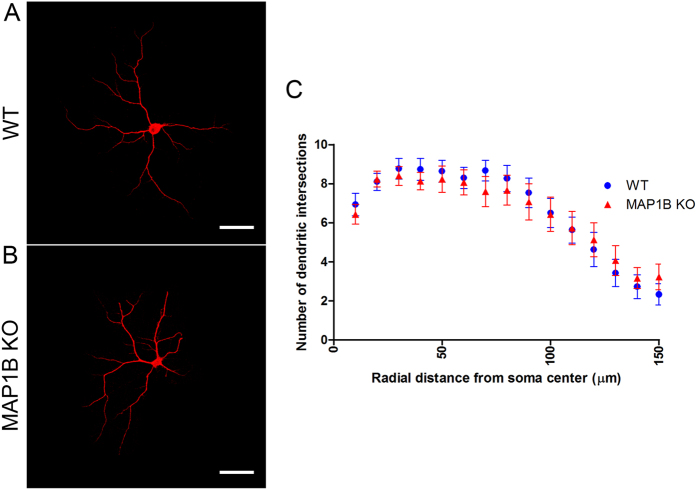
MAP1B KO neurons are unchanged in dendritic arbor complexity.Representative images of MAP2-stained WT (A) and MAP1B KO (B) mature hippocampal neurons. (C) Quantification of the intersection events between MAP2-positive dendrites and Sholl concentrical circumferences within 150 μm radial distance from the soma center. There are no differences between WT and MAP1B KO neurons at any of the radial distances analyzed. Two-way ANOVA p > 0.5 for each distance, n = 30 neurons for both genotypes.